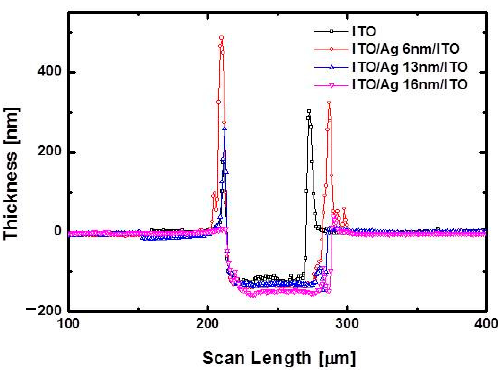
Figure 7. Surface profiles of laser-ablated ITO/Ag/ITO MLs with different Ag thicknesses at scanning speed of 500 mm/s for pulse energy of 97 μ J.